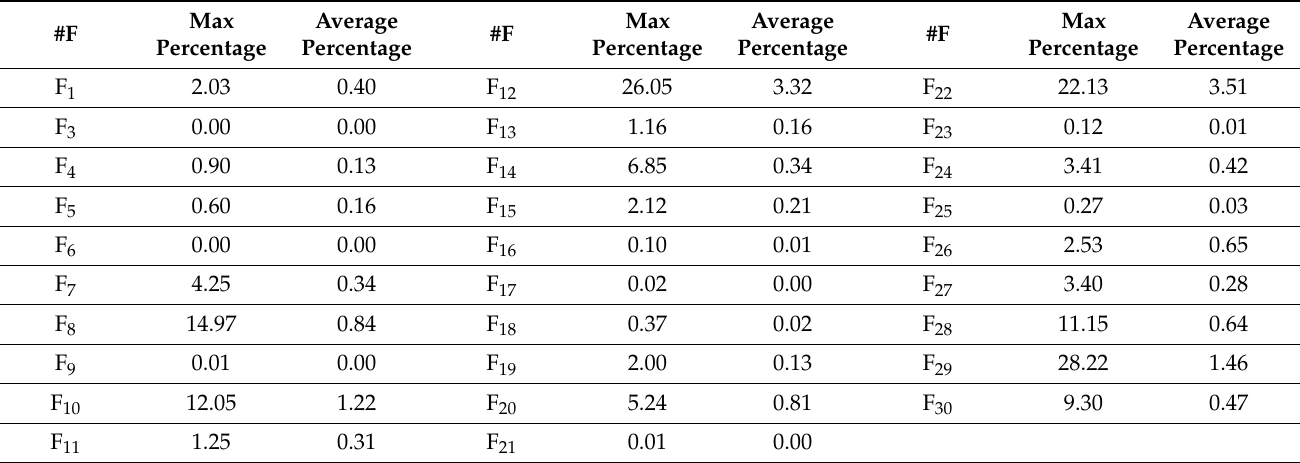
Table A1. The analysis of situations where ϕ i was equal to zero with D =